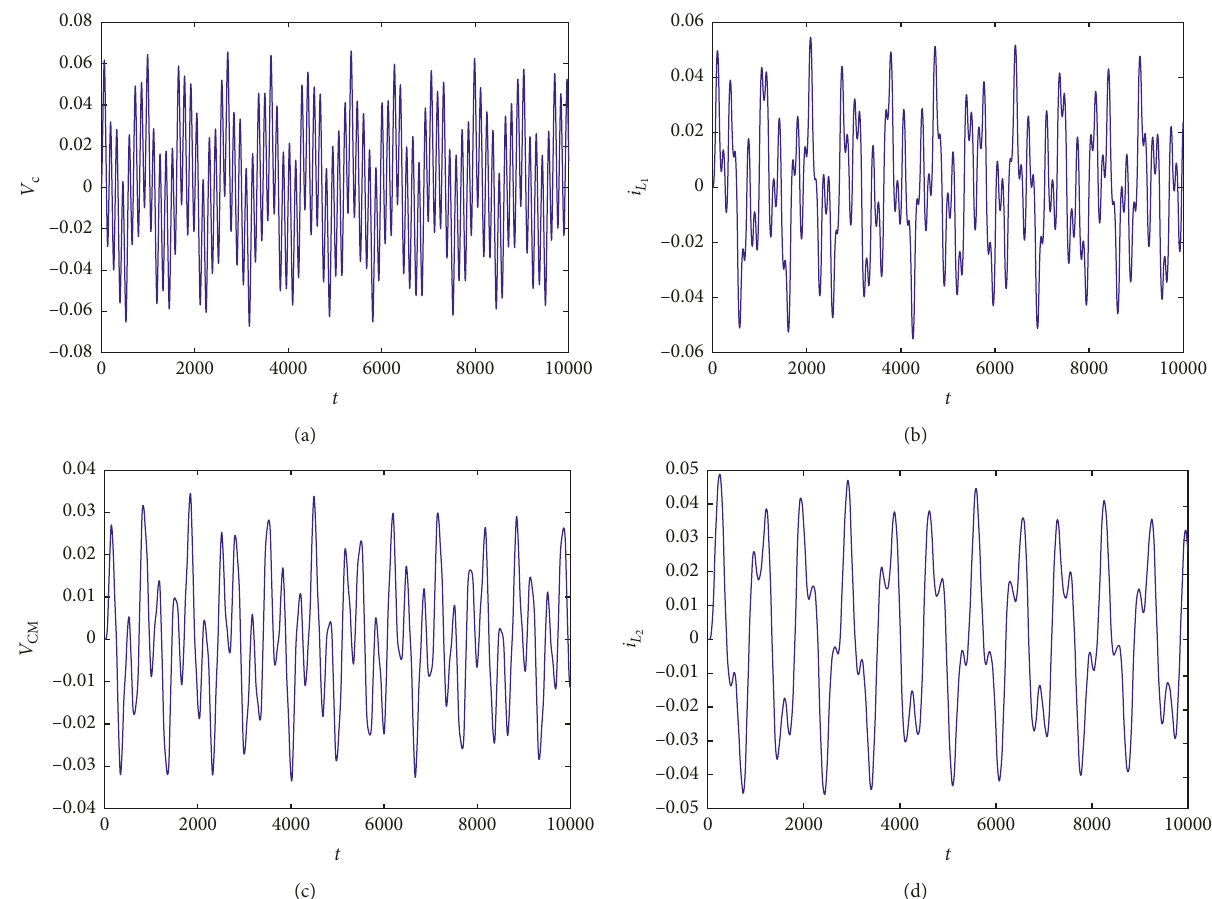
1 ; (c) voltage of C M ; (d) current flow of